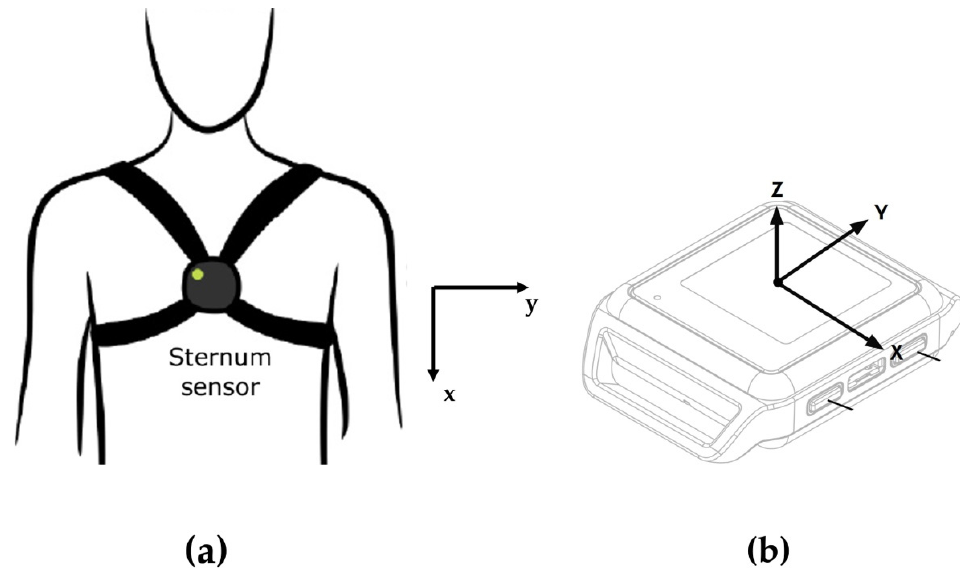
Figure 2. OPAL sensor and sensor positioning sketches. ( a ) OPAL sensor positioning sketch. Z axis is orthogonal (positive direction: towards the reader) to the x-y plane. ( b ) Isometric view (sketch) of the external shape of an OPAL sensor. ( a ): reproduced with permission from Martini et al., J. Physiother. Res.; published by Insight Medical Publishing (iMedPub), 2021. ( b ): reproduced with permission from Donisi et al., Sensors; published by Multidisciplinary Publishing Institute (MDPI), 2021.